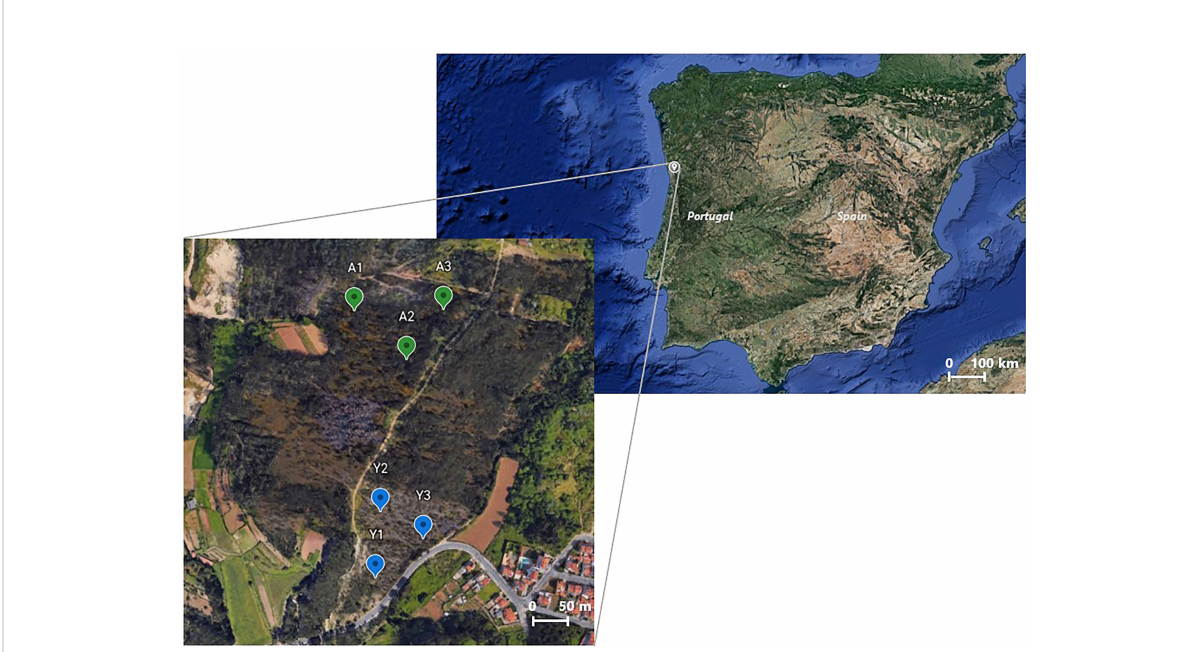
FIGURE 1 Sites of a burnt forest area where young (Y; Y1, Y2, and Y3) and mature (A; A1, A2, and A3) E. globulus leaves were harvested in February 2021. Retrieved from: Google